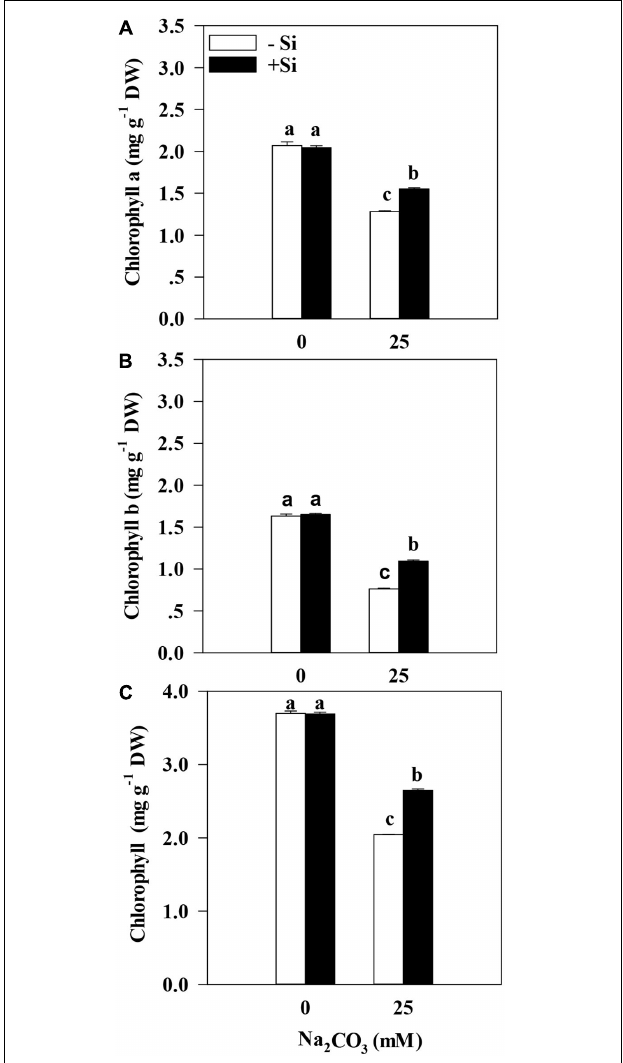
FIGURE 2 | Chlorophyll a content (A) , Chlorophyll b content (B) , and total chlorophyll content (C) in the leaves of alfalfa seedlings under Si priming in response to alkaline stress. –Si = pretreatment without Si; +Si = pretreatment with Si. Values are means ± SE, n = 25. Different letters denote significant difference ( P < 0.05) based on Duncan’s